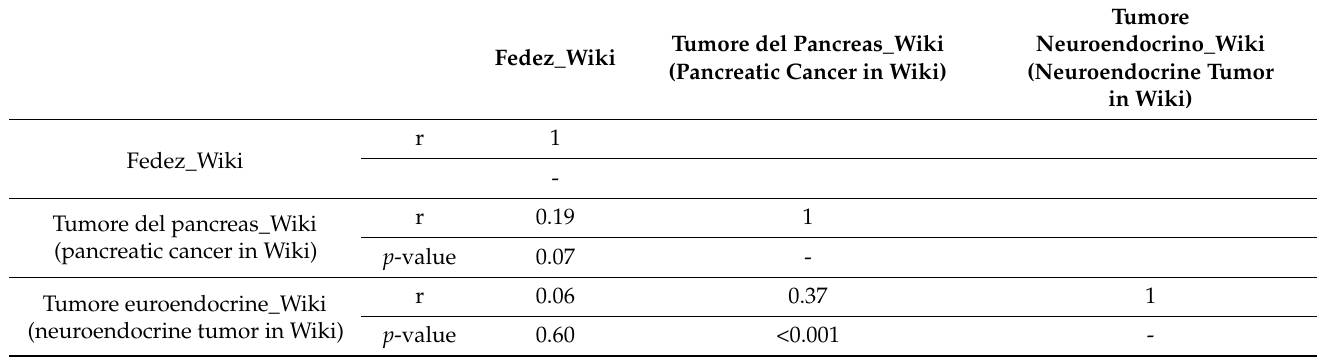
Table 2. Pearson’s correlation coefficient (r) for Wikipedia searches in Italy from July 2015 to October 2022.